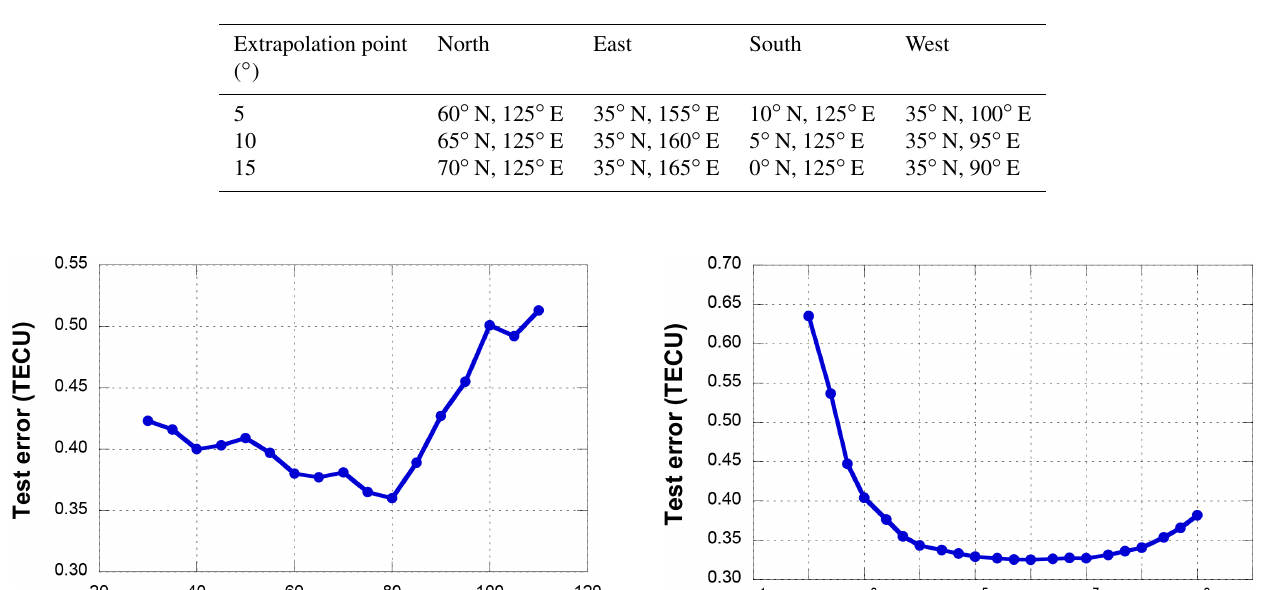
Table 1. The locations of the extrapolation points.